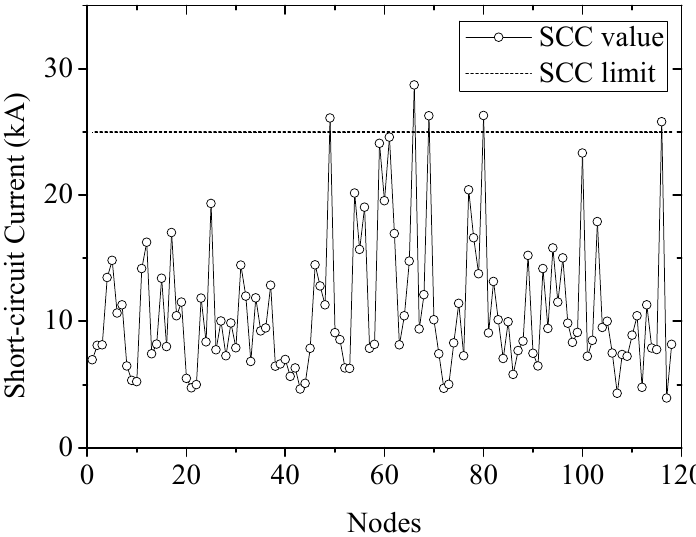
Figure 4. The short-circuit current magnitudes of all the buses in IEEE 118-bus system before transmission switching.